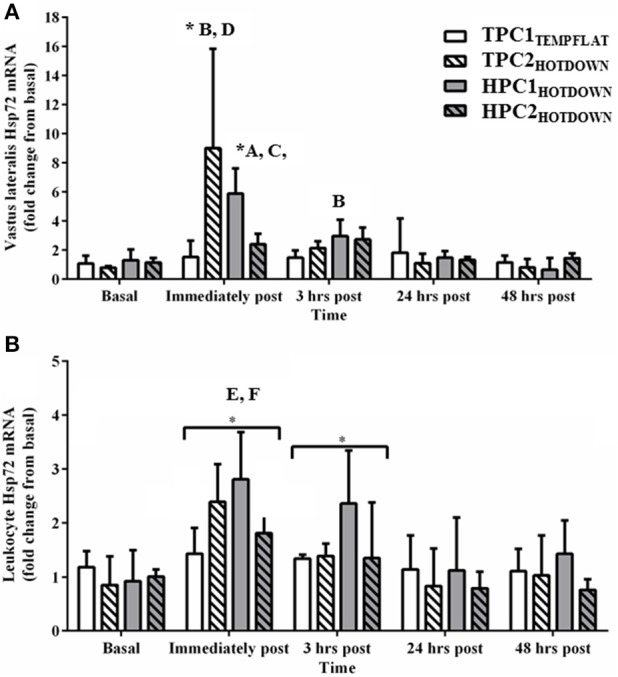
Hsp72 mRNA response immediately before, immediately post, 3 h post, 24 h post and 48 h post exercise in the Vastus lateralis (A) and Leukocytes (B). * Increased (p < 0.001) compared to basal. A, increased (p = 0.020) in HPC1HOTDOWN compared to TPC1TEMPFLAT. B, increased (p < 0.001) in TPC2HOTDOWN compared to TPC1TEMPFLAT. C, increased (p = 0.028) in HPC1HOTDOWN compared to HPC2HOTDOWN. D, increased in TPC2HOTDOWN compared to HPC2HOTDOWN. E, HPC1HOTDOWN increased (p = 0.049) compared to HPC2HOTDOWN. F, HPC1HOTDOWN increased (p = 0.003) compared to TPC1TEMPFLAT. Data presented as median ± interquartile range.